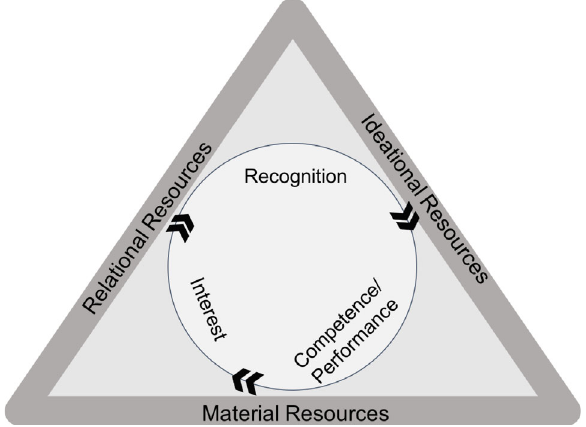
FIG. 8. Preliminary model for the Critical Physics Identity framework